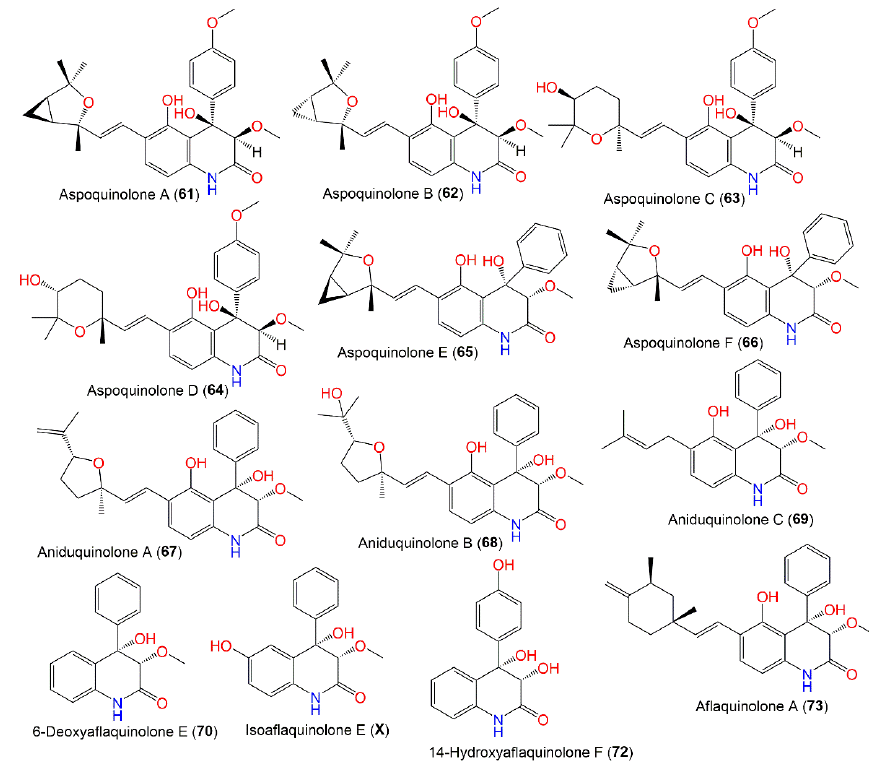
Figure 6. Structures of quinoline alkaloids ( 61 – 73 ). Table 5. Quinoline alkaloids reported from Aspergillus nidulans .